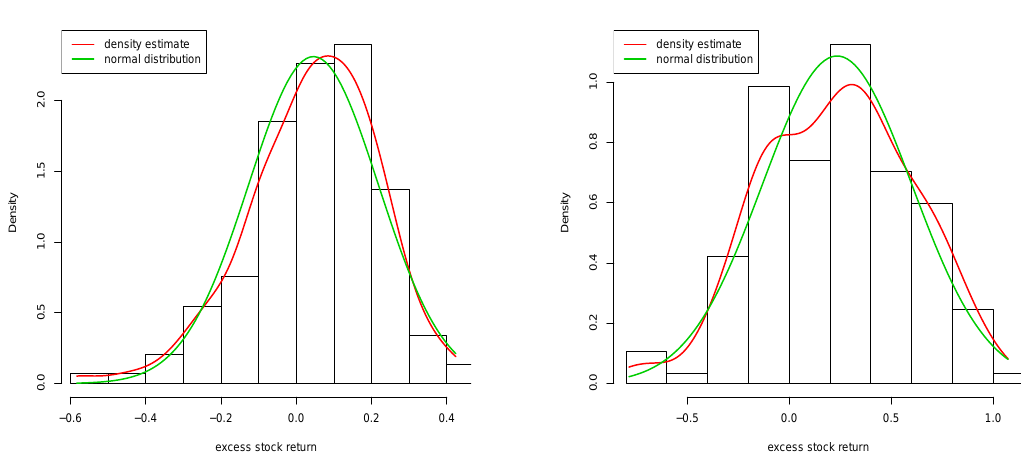
Figure 3. Histogram, kernel density estimate (red), and fitted normal distribution (green). ( Left ) one-year stock returns in excess of the risk-free benchmark. ( Right ) five-year stock returns in excess of